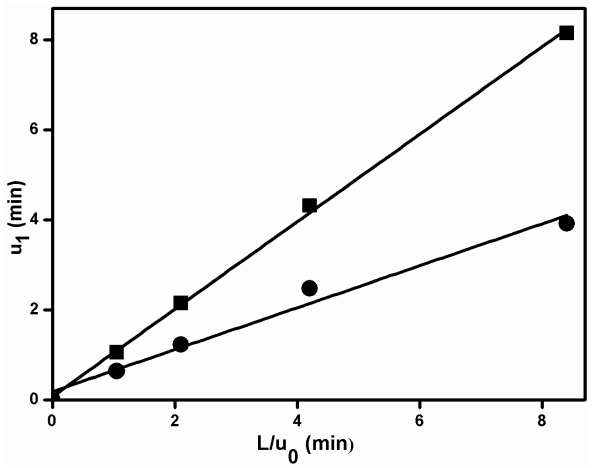
Figure 4. First moment versus L/ column packed with Q fibrous